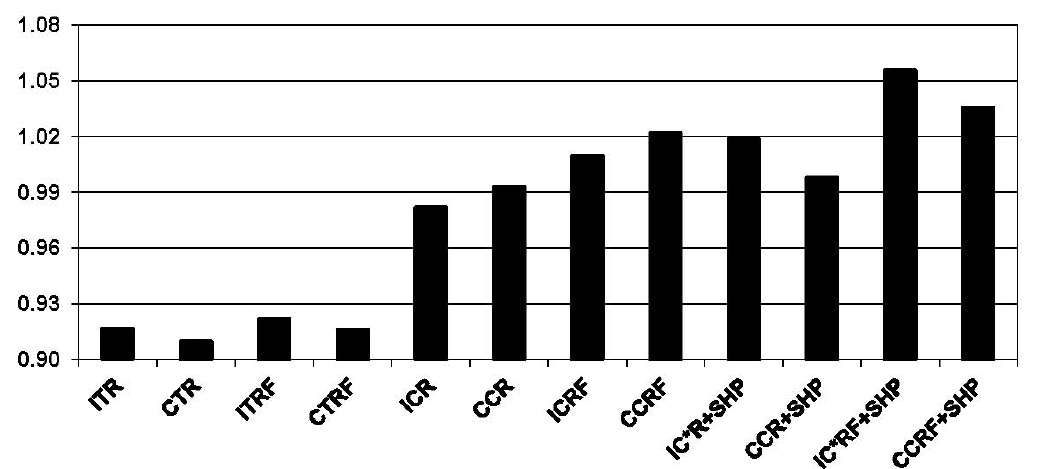
Figure 5. Boiler efficiency of heating